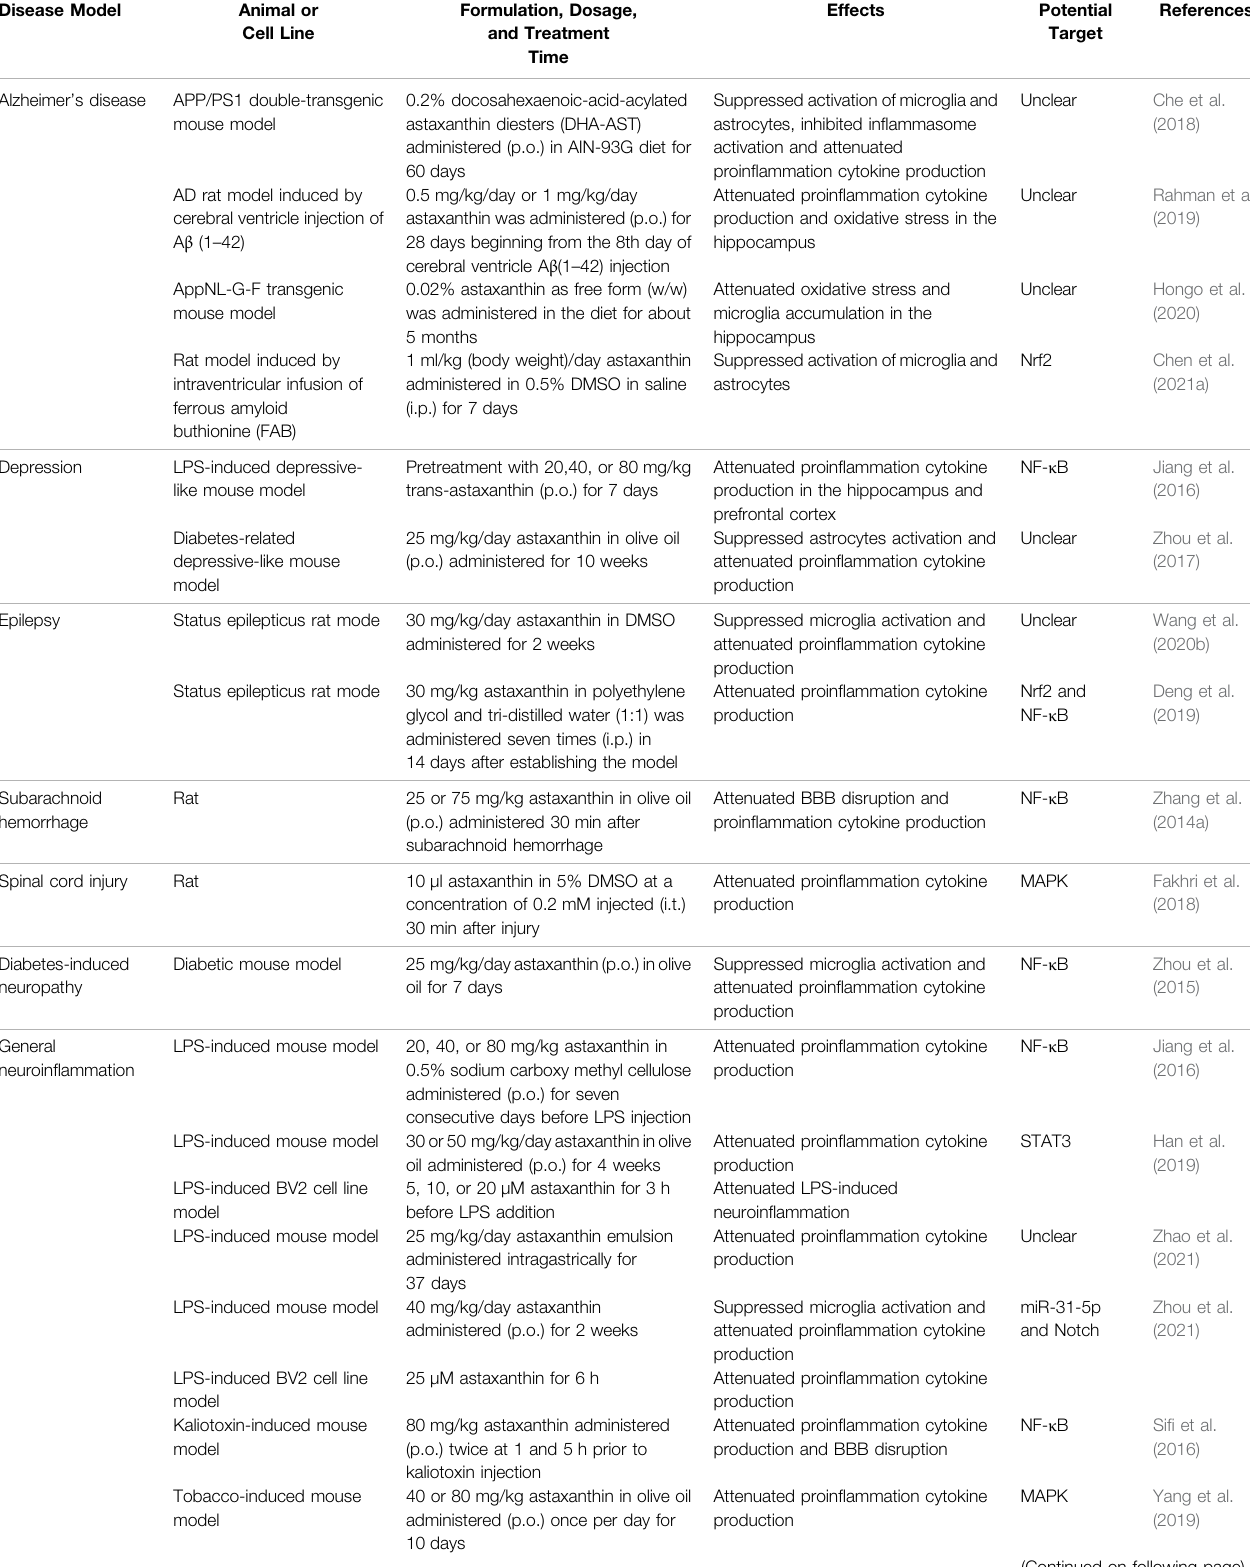
TABLE 1 | Effects and potential mechanisms of astaxanthin in modulating neuroin fl ammation. Disease